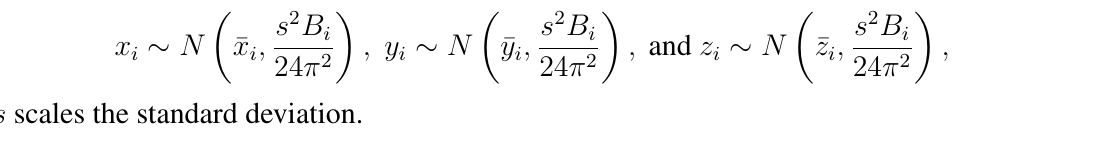
Figure 5. An unperturbed depiction of 1QMPa is shown on the left, and a sample from a random model of the same protein chain is shown in the center ( s = 1 ). The image on the right is an overlay of all nuclear magnetic resonance (NMR) renderings of